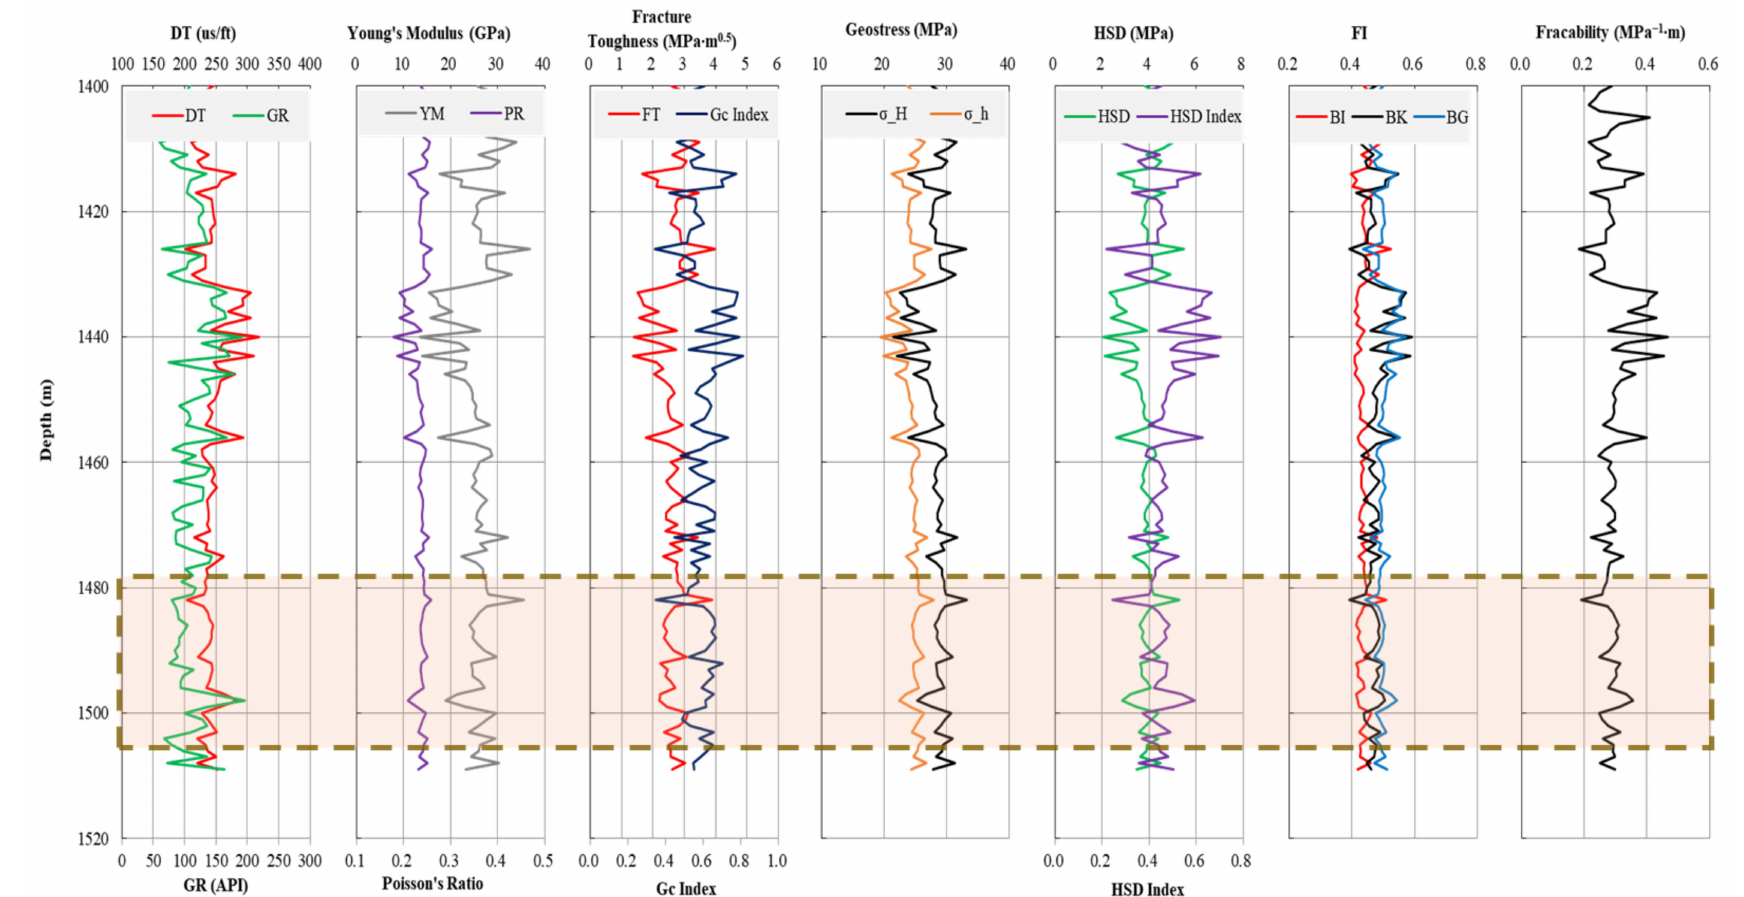
Figure 8. Profiles of fracability and other key parameters from Well